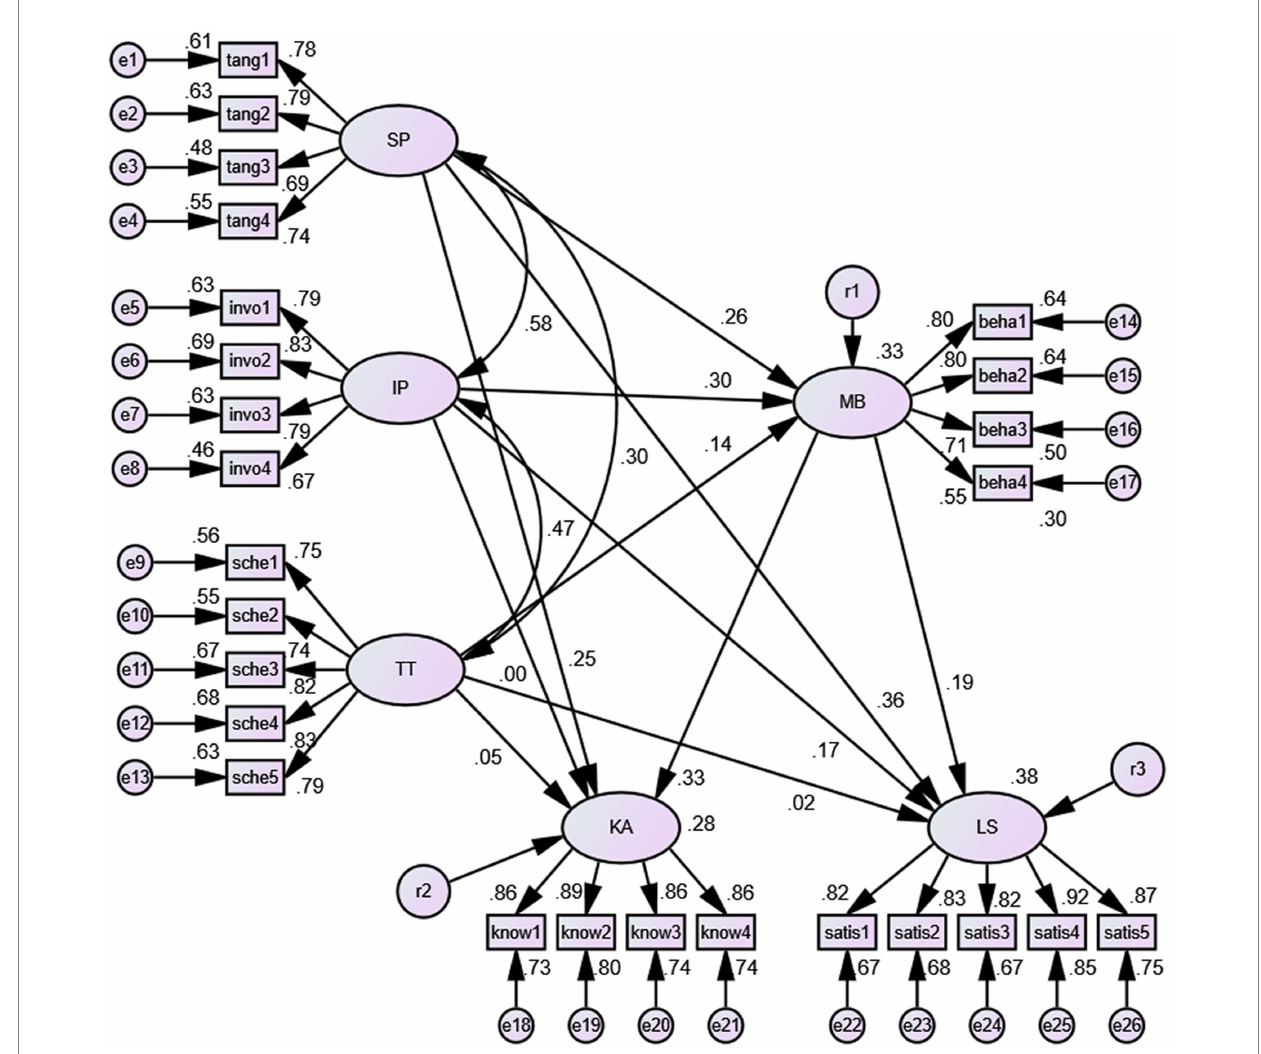
FIGURE 2 The standardization coefficient pattern of the SEM for the high school student sample. SP = Scheduling preference, IP = Involvement with people, TT = Time tangibility, MB = Multitasking behavior, KA = Knowledge acquisition, LS = Learning